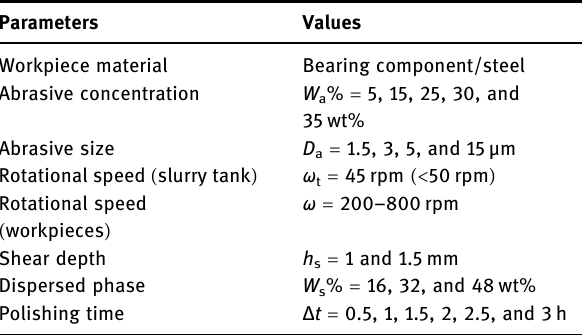
Table 1: Detailed experimental data Parameters Values Workpiece